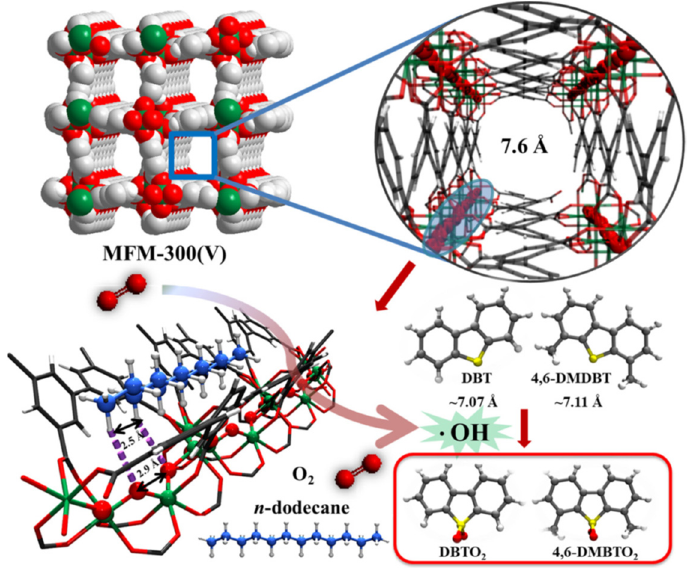
Figure 6. Proposed reaction mechanism over MFM-300(V) in ODS of DBT under ambient air atmosphere [57].